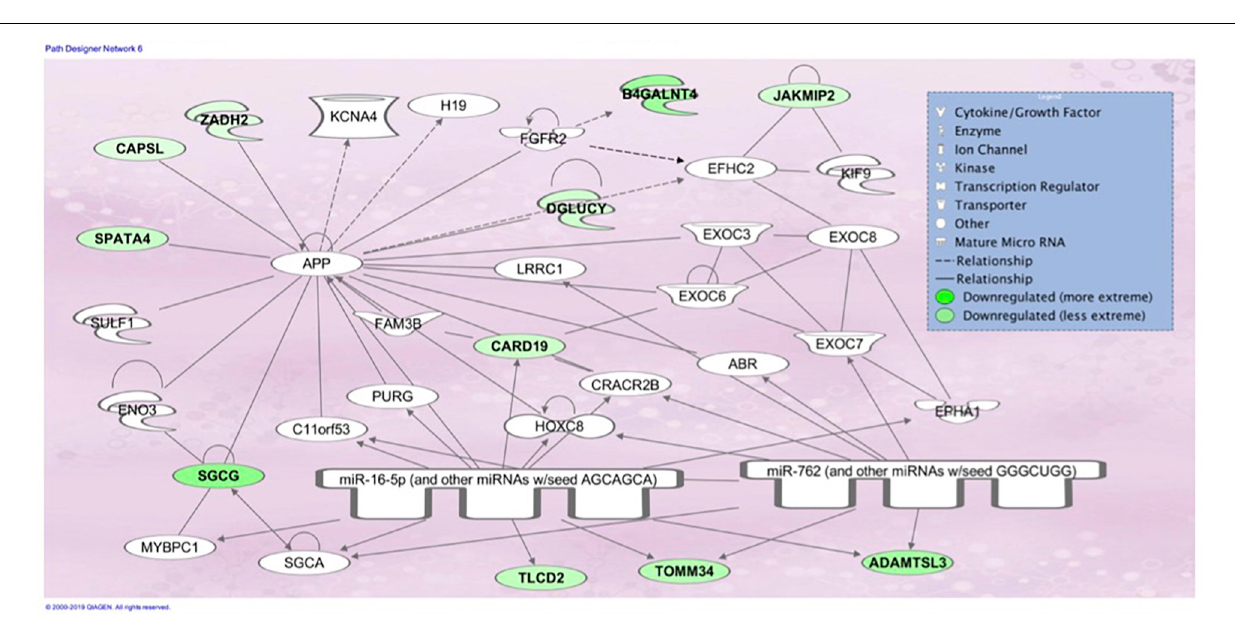
FIGURE 6 | Associated network function in IPA for the liver transcriptome dataset of birds with normal PM compared to severe/moderate WB: Skeletal and Muscular System Development and Function, Developmental Disorder, Hereditary Disorder